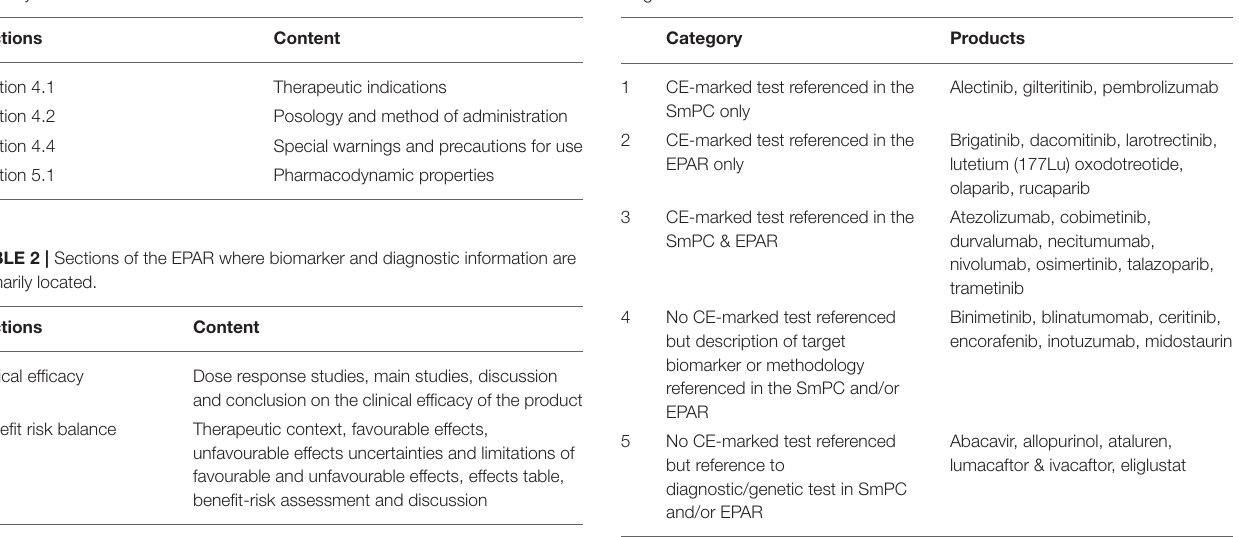
TABLE 3 | Grouping of medicinal products based on reporting of biomarkers and diagnostic